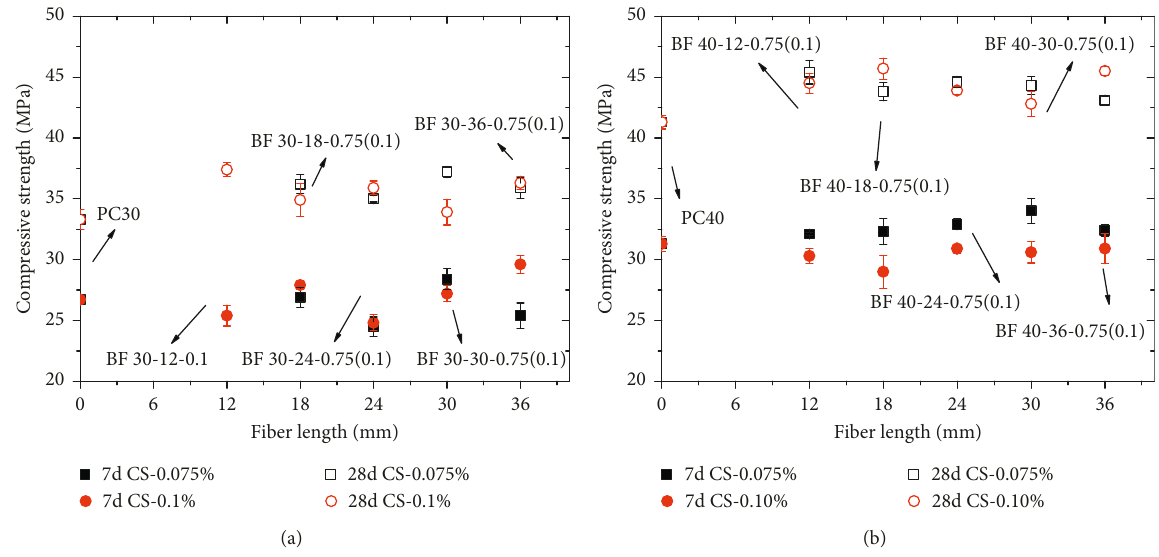
Figure 5: Effect of fiber length variation on compressive strength for specimens PC30 (40) and BF 30(40)-(12 ∼ 36)-0.075(0.1): (a) design CS of 30MPa and (b) design CS of 40